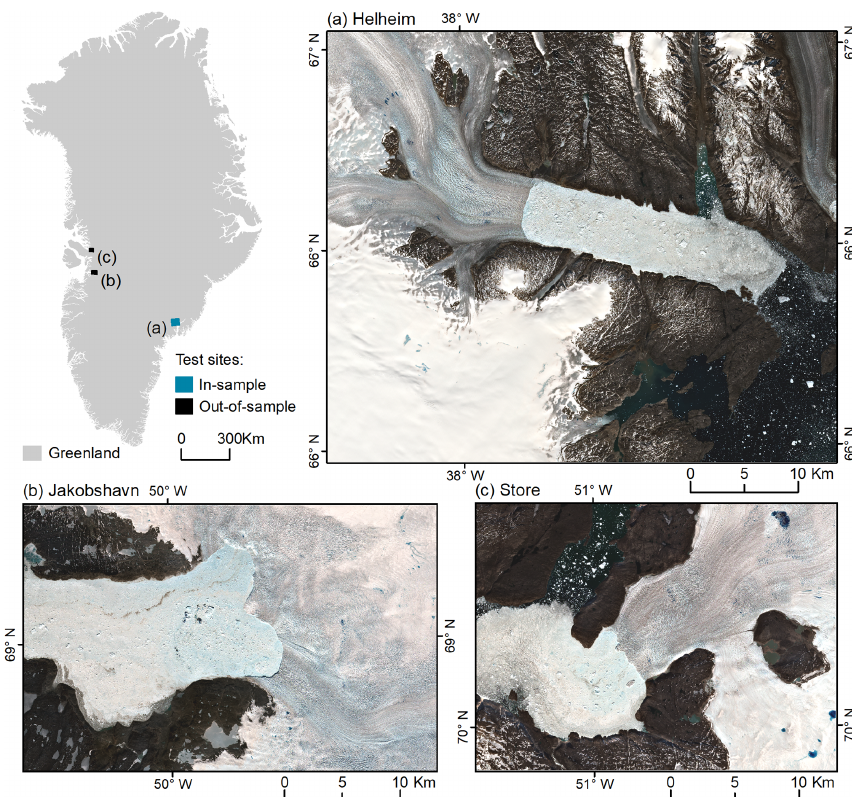
Figure 3. Test areas used to quantify the transferability of the CSC workflow. (a) The in-sample test area including Helheim Glacier. Example image acquired on 18 June 2019. (b) The out-of-sample test areas of Jakobshavn Isbrae (example image acquired on 21 May 2020) and (c) Store Glacier (example image acquired on 28 June 2020). The outline of Greenland is from Gerrish (2020), and all Sentinel-2 imagery in this figure has been made available courtesy of the European Union Copernicus